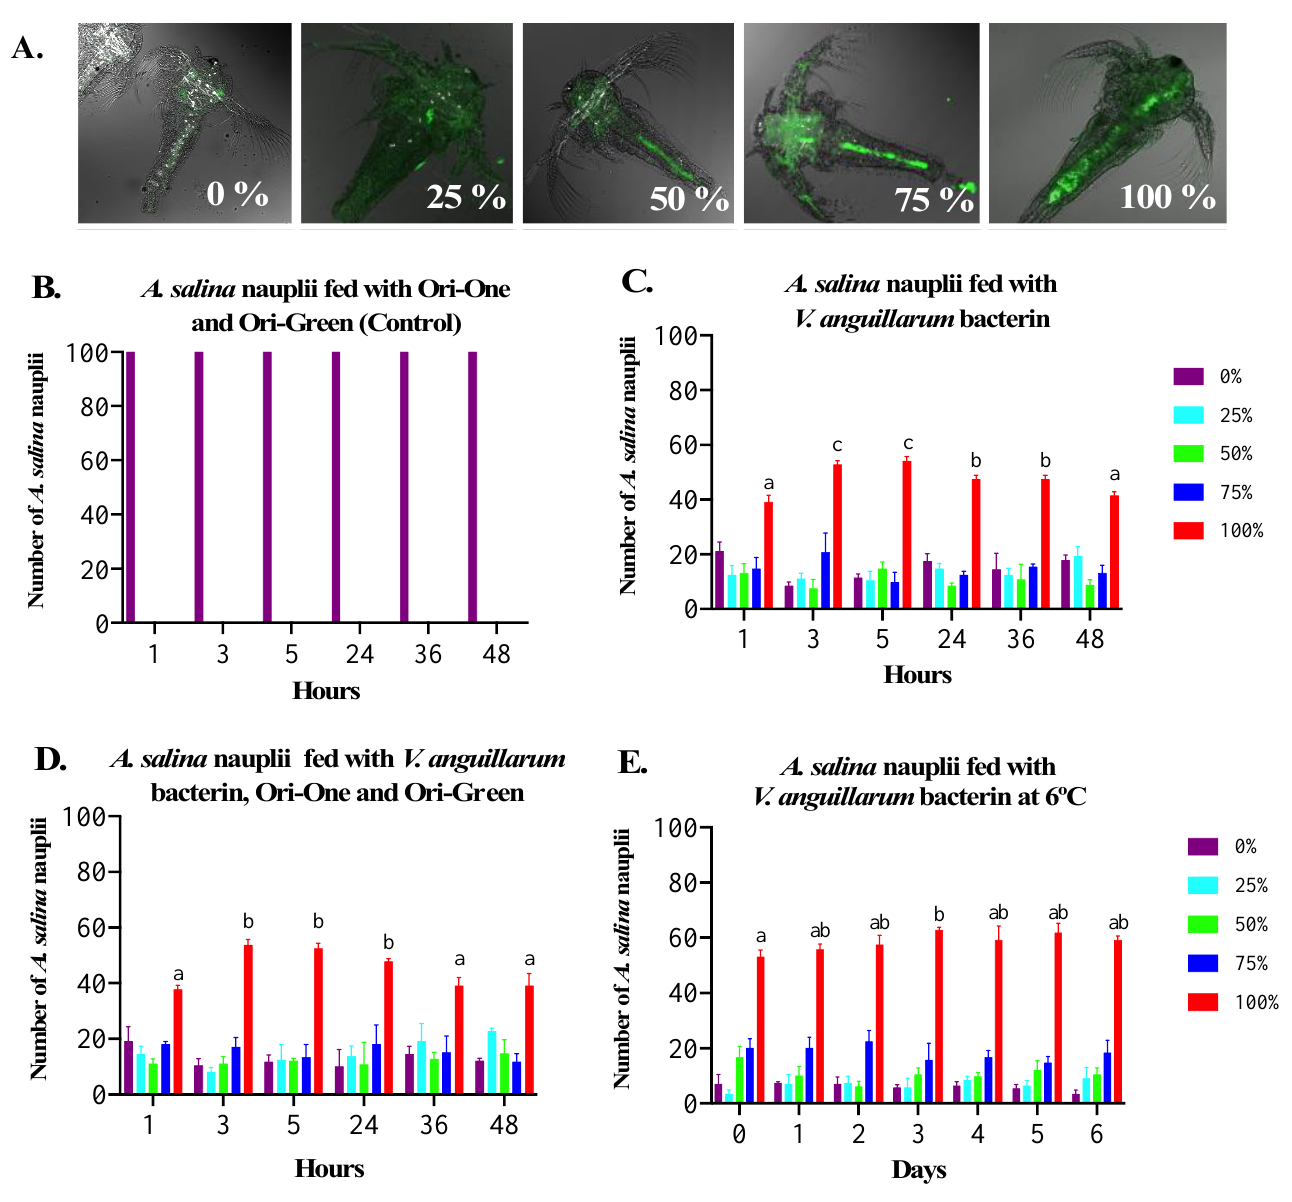
Figure 2. Optimization of V. anguillarum bacterin bio-encapsulation in A. salina nauplii. ( A ). Relative percentage of DTAF-labeled V. anguillarum bacterin in A. salina nauplii intestine; ( B ) A. salina nauplii suplemeted with dry microalgae (Ori-One and Ori-Green) as autofluorescence control. A. salina fed with commercial dry microalgae (Ori-One and Ori-Green) at 20 ◦ C; ( C ) V. anguillarum bacterin bio-encapsulation in A. salina nauplii at 20 ◦ C; ( D ) V. anguillarum bacterin and commercial dry microalgae bio-encapsulation in A. salina nauplii at 20 ◦ C; ( E ) bio-encapsulation stability at 6 ◦ C after 3 h post enrichment with V. anguillarum bacterin at 20 ◦ C. In all cases, different color bars represent the % bio-encapsulation levels of the V. anguillarum bacterin in A. salina nauplii. Each value is the mean ± SEM for 3 groups of 100 A. salina nauplii per group. Different letters (a, b, c) indicate the differences in the numbers of A. salina nauplii enriched with 100% V. anguillarum bacterin at different time points. Means with different letters differ significantly ( p < 0.05). Bars represent mean ±